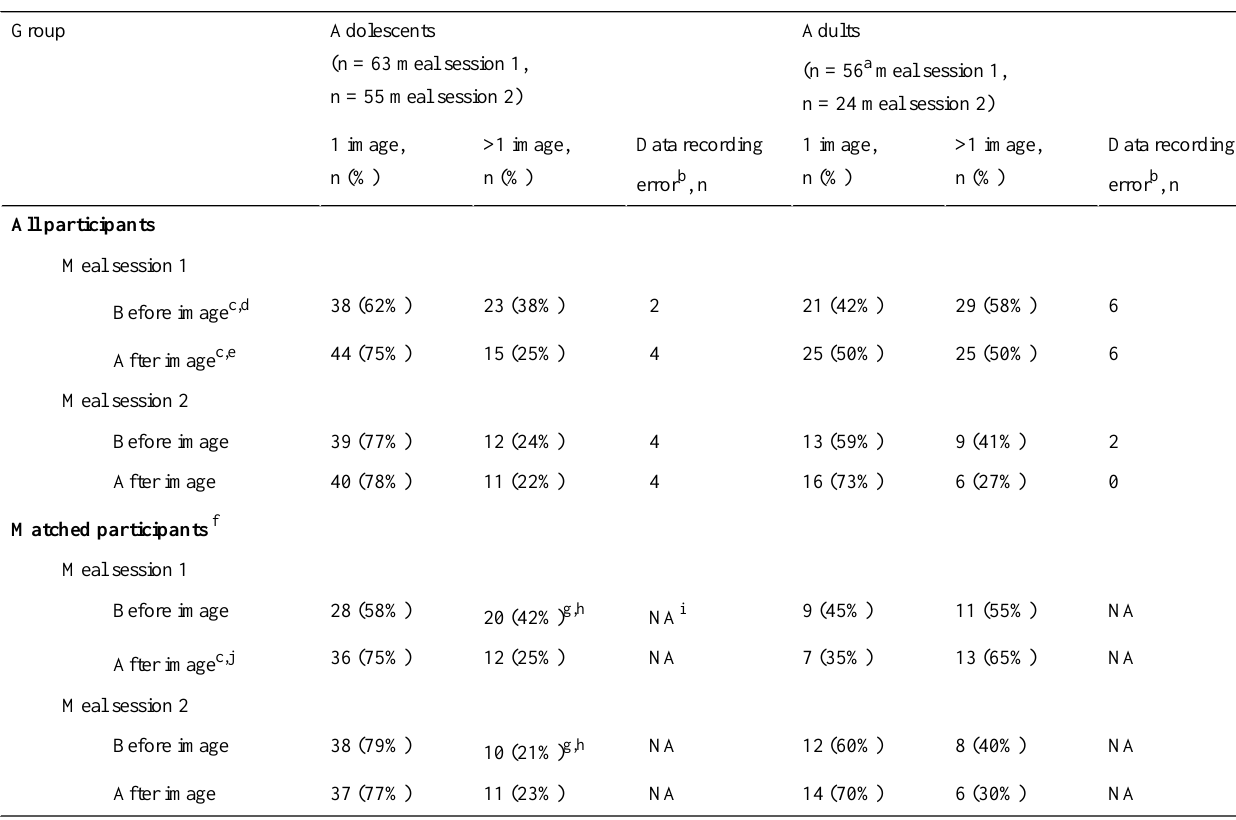
Table 3. Comparisons between and within adolescents and adults of the number of images acquired prior to obtaining a suitable